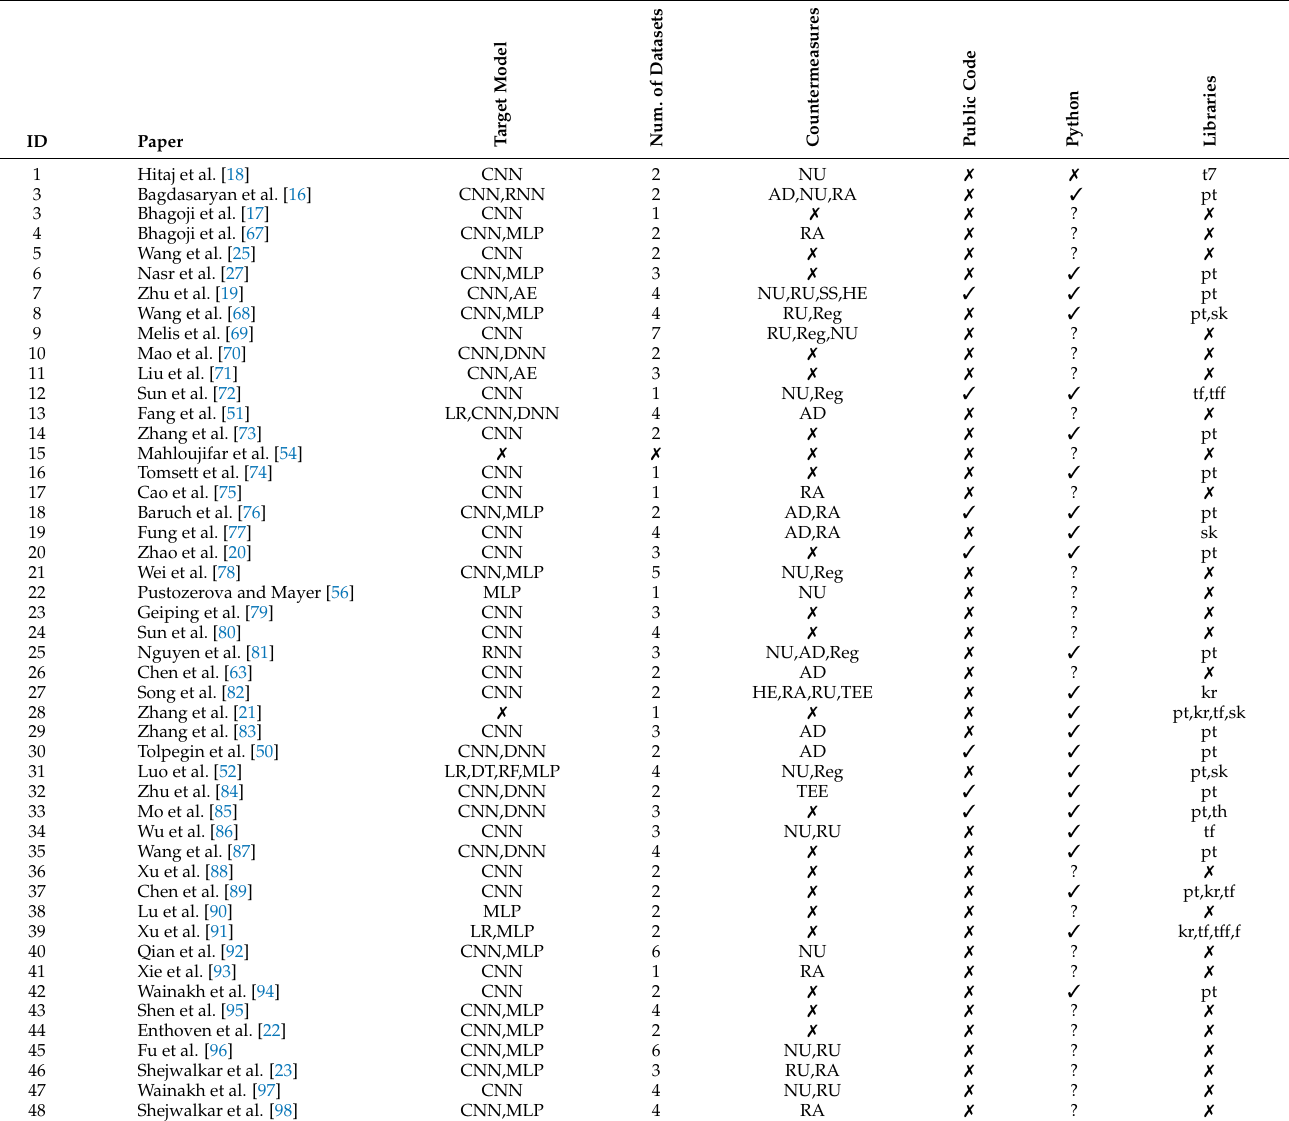
Table 5. Mapping results for the studied papers with regard to evaluation